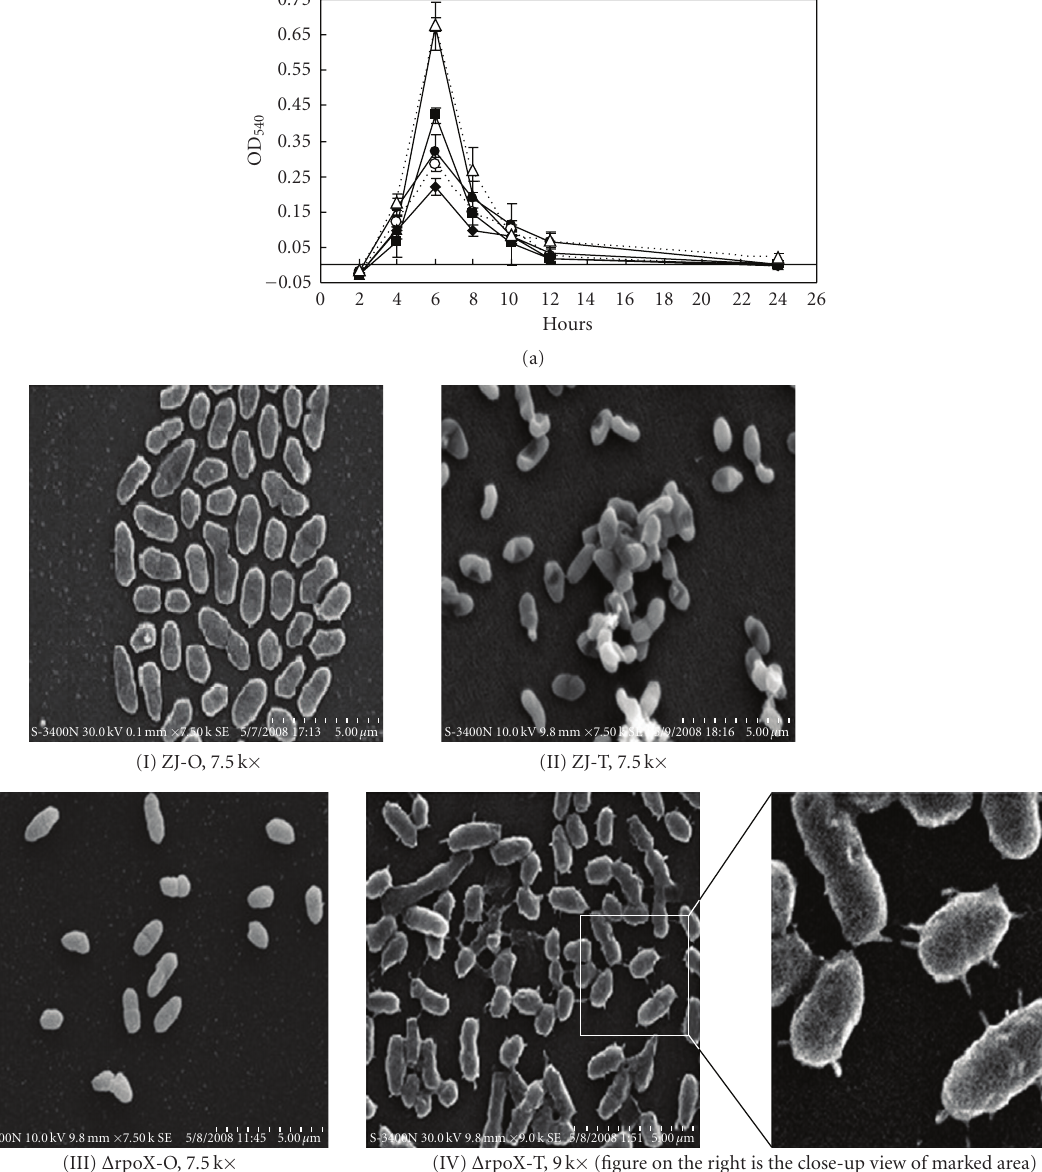
Figure 5: (a) Kinetics of biofilm formation of the V. alginolyticus ZJ-51 , wild type (Op: closed circle; Tr: closed triangle), rpoX null mutant (Op: closed diamond; Tr: closed square), and complemented strains (Op: open circle; Tr: open triangle). Bacteria were grown in BF medium in a 24-well polystyrene plate that was incubated statically at 30 ◦ C for 2, 4, 6, 8, 10, 12, and 24 hours. Cells were processed as mentioned in Materials and Methods section. Biofilms were quantified by measuring the OD at 540 nm. (b) Observation of biofilm structures by SEM S-3400N: (I) ZJ-O, 7.5k × , (II) ZJ-T, 7.5 k × , (III) Δ rpoX -O, 7.5k × , (IV) Δ rpoX -T, 9.0k ×